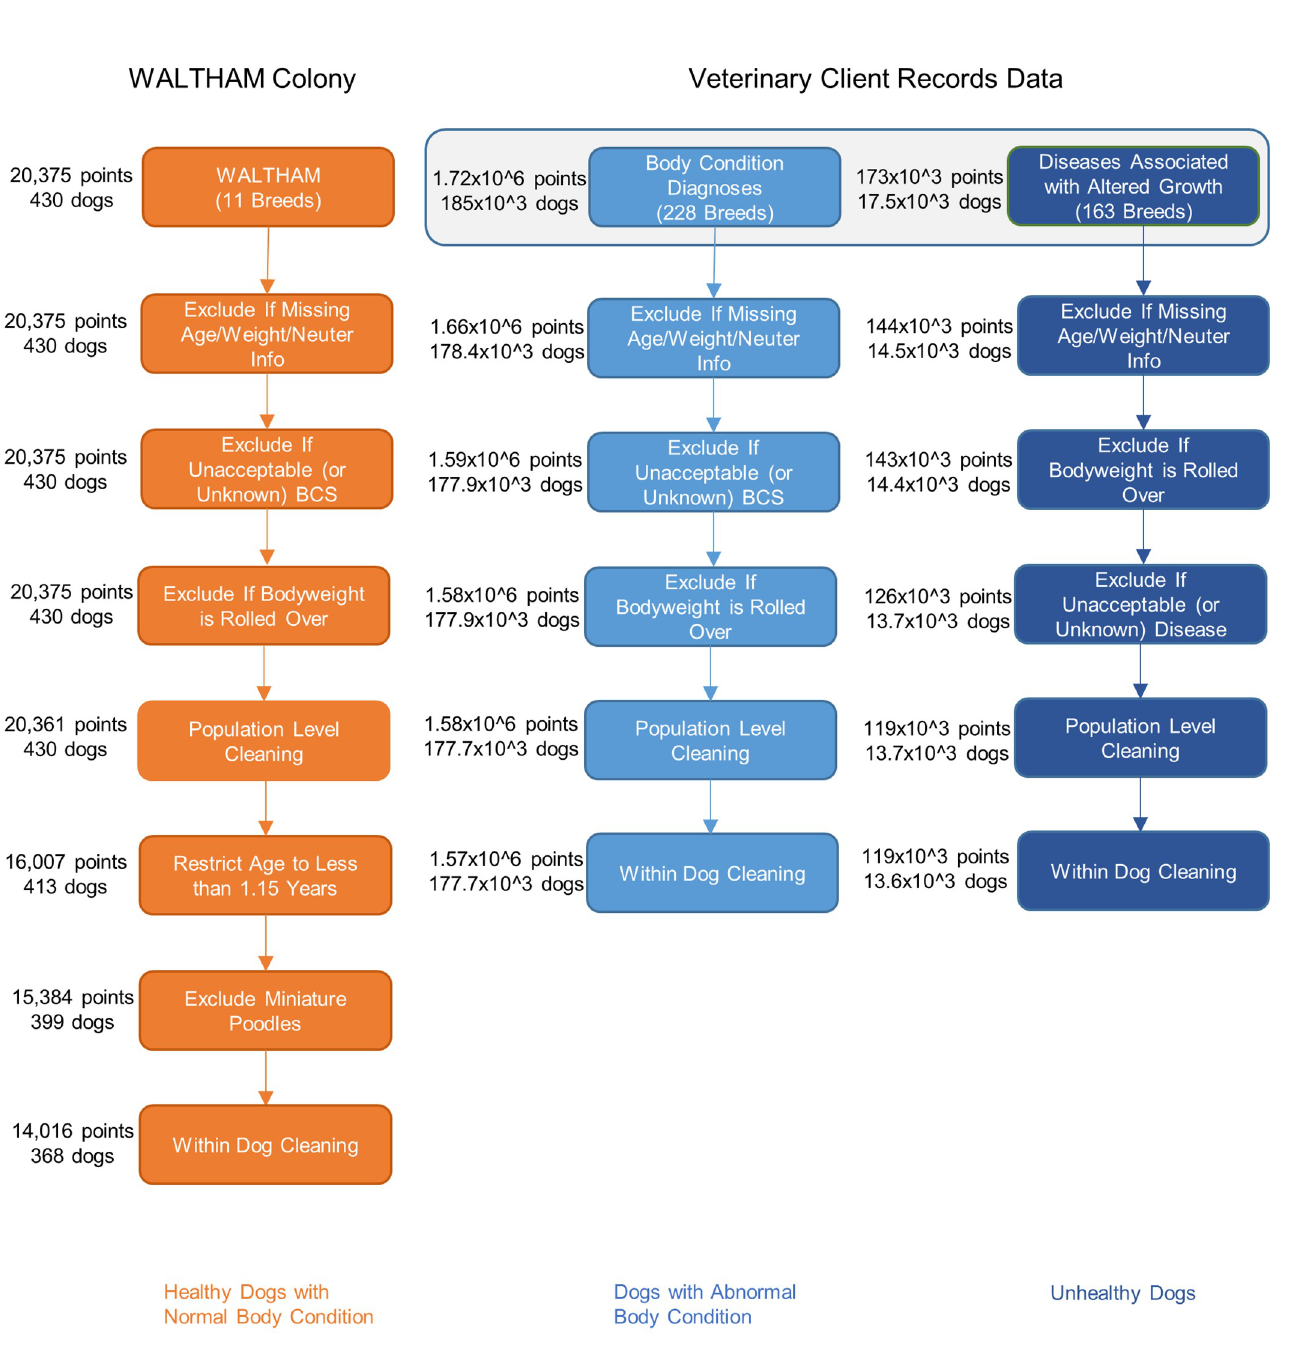
Fig 1. Flow diagram illustrating the data cleaning process. This cleaning process was used for datasets used in the creation of the predicted median growth trajectories. Data are expressed as either thousands (10 3 ) or millions (10 6 ) as appropriate.